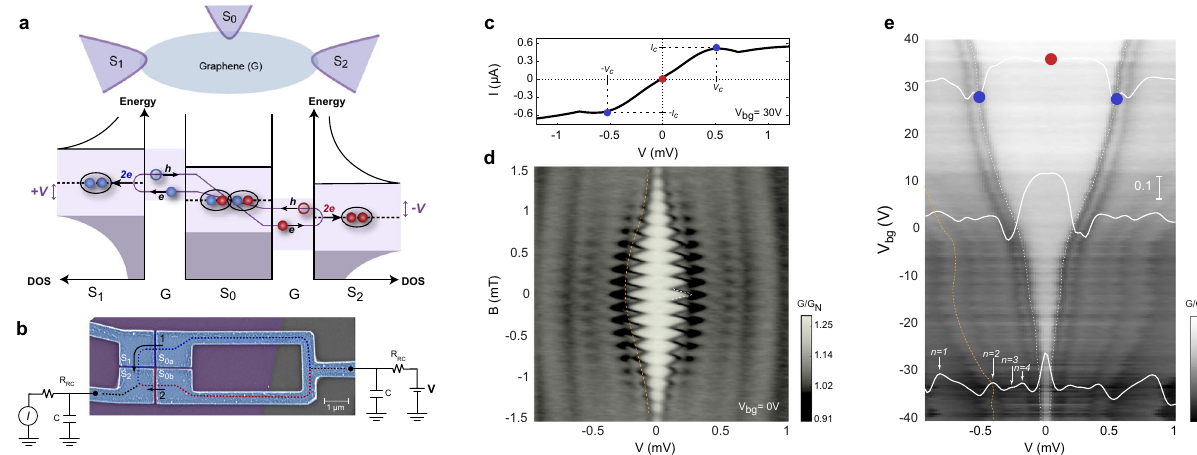
Fig. 1 Illustration of quartet formation and a single source voltage bias characterization of four-terminal Josephson junction including a loop. a Schematic illustration of the three-terminal quartet process with the Andreev re fl ection picture. The middle superconductor S 0 is grounded while the other two superconductors are biased at + V , − V , respectively. The two entangled Cooper pairs (with red and blue electrons) are formed in S 0 through two local Andreev re fl ections and two crossed Andreev re fl ections. b False color scanning electron microscopy (SEM) image of the device with measurement con fi gurations. Graphene (purple) is top-contacted by Ti/Al superconducting electrodes (blue) and the electrode separations typically are 80 – 100 nm. Here we split S 0 in a into to two contacts S 0 a ; S 0 b connected by a loop, c I (cid:3) V curve of the device from the measurement con fi guration in b I c is the critical current and the corresponding voltage value is labeled as V c (the blue dots). d Magnetic fi eld dependence, dI/dV as a function of the bias voltage and magnetic fi eld. Bright region (high conductance) is the supercurrent and the edge corresponds to the value of critical current, which is modulated by the magnetic fi eld. The SQUID-like pattern indicates the interference between two supercurrent paths (red and blue dashed lines in b ). The periodicity of the fast oscillation (white dashed curve) corresponds to the loop area and the slow oscillation (yellow dashed curve) is the fi rst lobe of Fraunhofer pattern. e Gate dependence of the supercurrent, dI/dV as a function of the bias voltage and global back-gate voltage V bg . The critical current reaches the minimum as graphene is tuned to the Dirac point near V bg = − 32